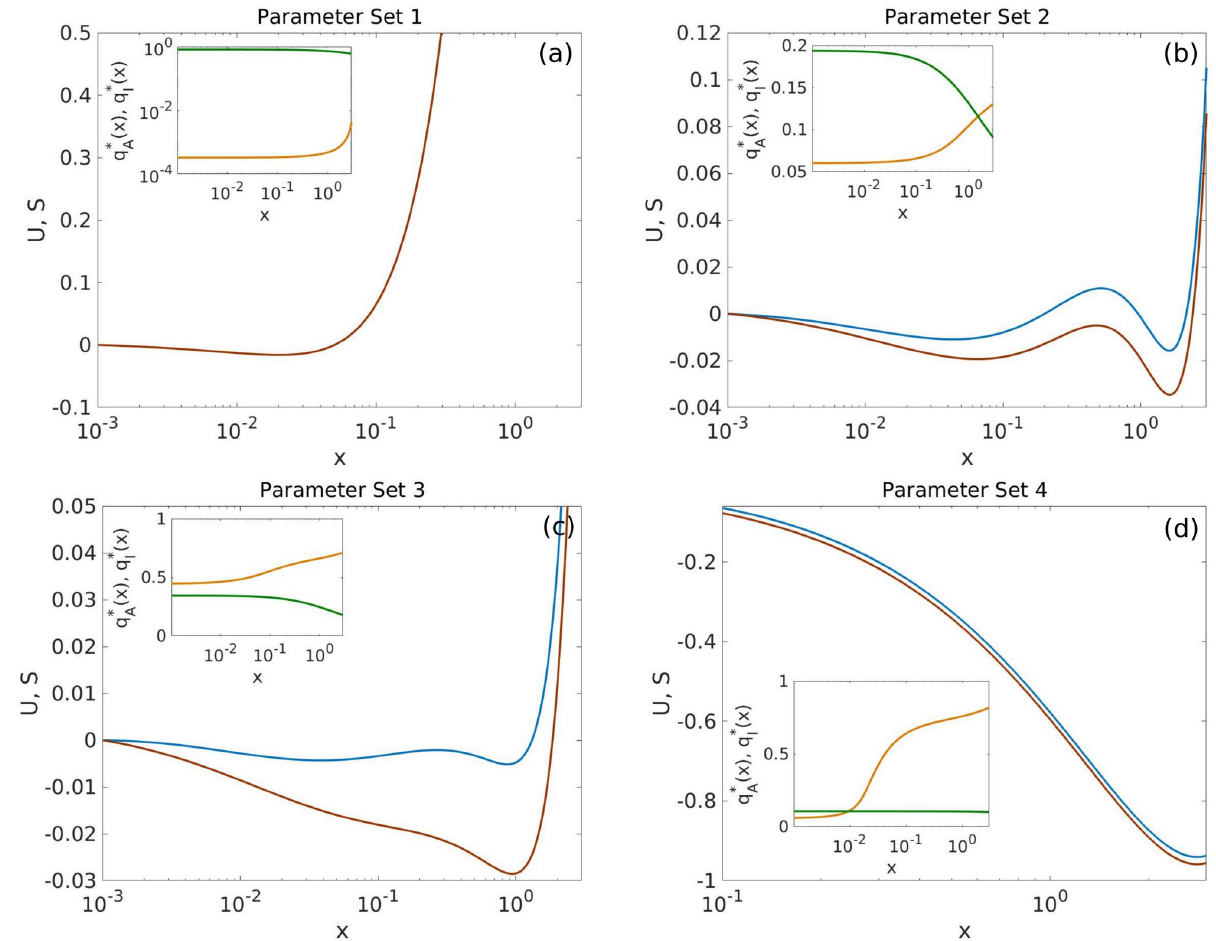
Fig 3. Representative examples of the four sub-ensembles. Plot (a) shows an example of a monostable, low gene expression system, belonging to the Low GE sub-ensemble. Plots (b) and (c) show examples of systems within the bistable and the noise-induced Bistable sub-ensembles, respectively. Plot (d) shows an example of a monostable, high gene expression system, belonging to the high GE sub-ensemble. See main text for details. Colour code: Red lines show S 0 ð x Þ , blue lines correspond to U 0 . Green and orange lines within the insets represent q � given in Tables F-I of S1